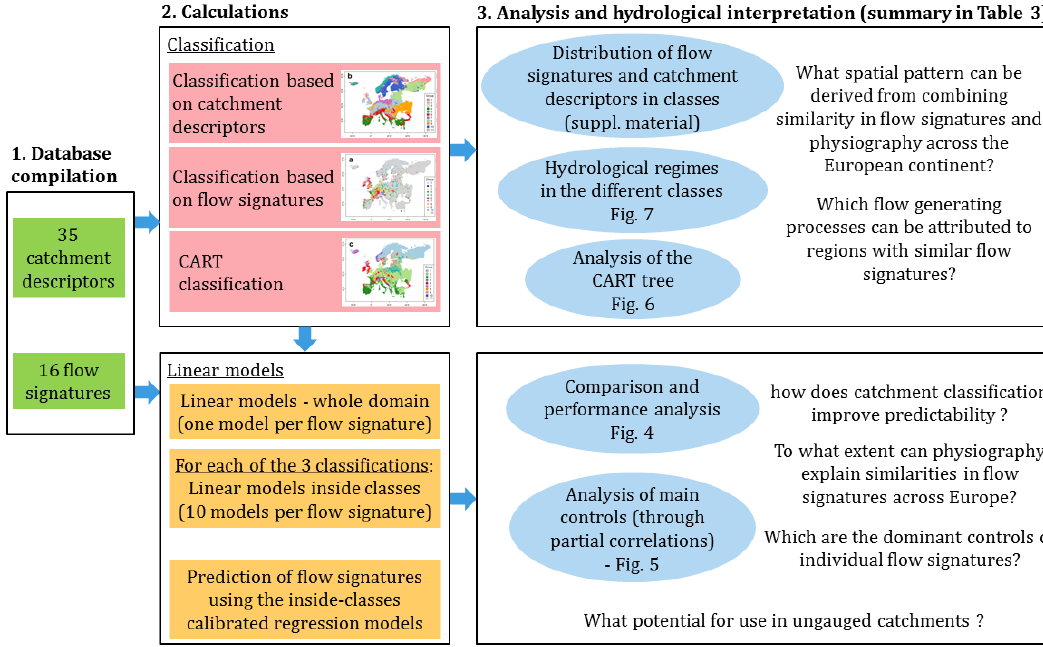
Figure 1. Flow chart of the different steps followed in the study.